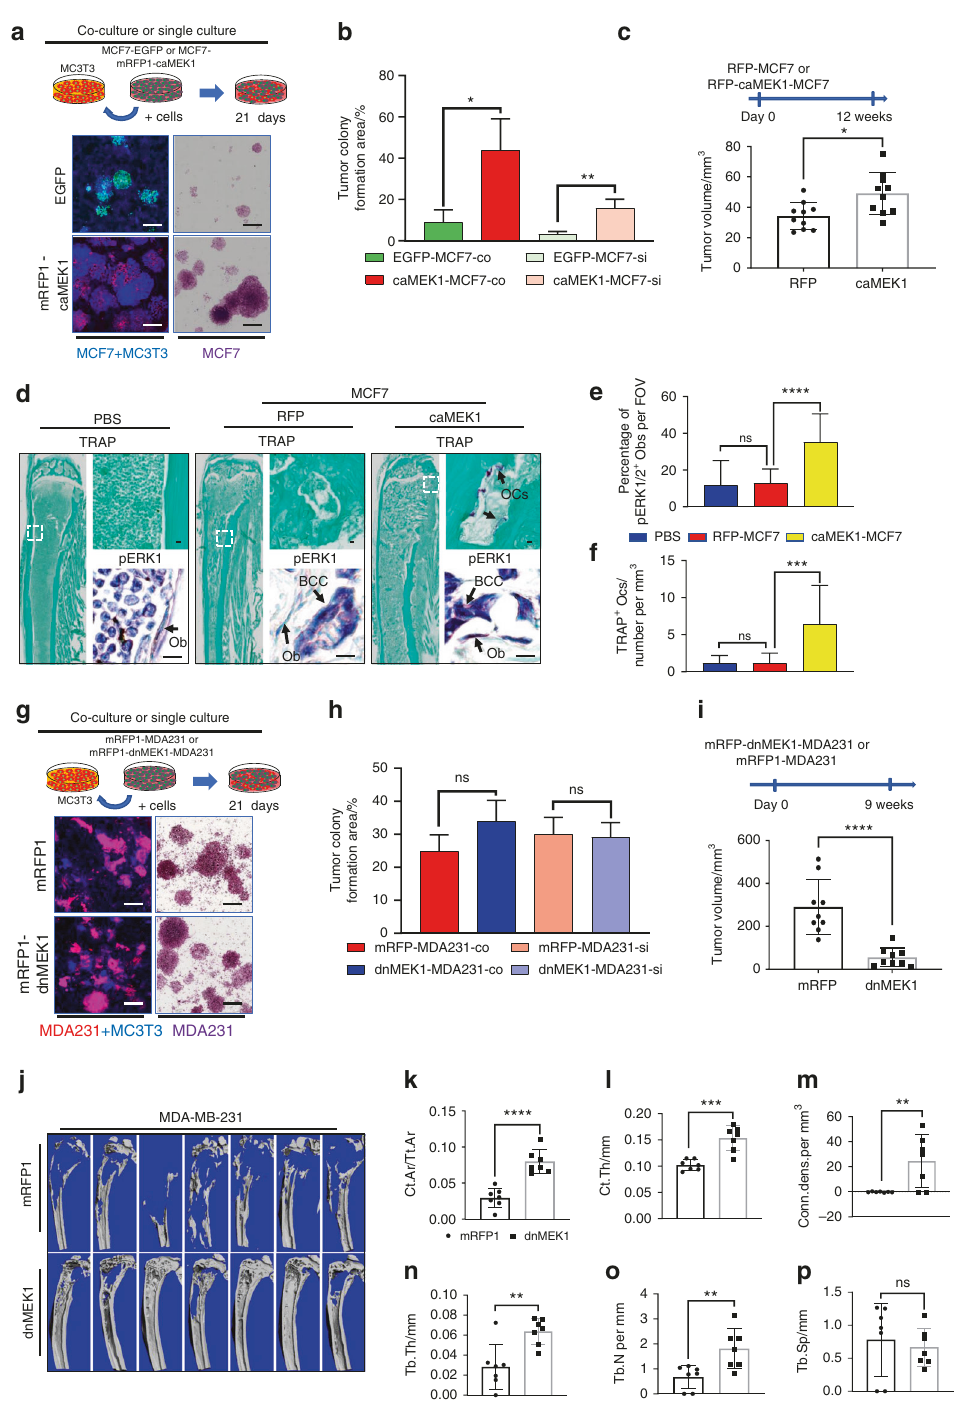
Fig. 4 MEK1/ERK1/2-mediated in fl ammatory interactions between aggressive breast cancer cells and osteoblasts accelerate bone destruction and cancer growth. a ERK1/2 activation in MCF7 cell growth under both single culture conditions and coculture conditions. b BCC colony formation was quanti fi ed by colony formation area. The mean colony area size was computed from images from the experiment in ( a ). Scale bar, 200 μ m. c caMEK1 expression in MCF7 cells in bone destruction and cancer growth. n = 10 mice per group. d pERK1/2 immunostaining and TRAP staining of tibiae harvested from the mRFP-MCF7- or mRFP-caMEK1-MCF7-exposed mice. Scale bar: 100 μ m. e Quanti fi cation of TRAP + osteoclast number under different experimental conditions. TRAP + osteoclast number calculated from images from the experiment in ( d ). f Quanti fi cation of pERK1/2 + osteoblasts in murine tibiae with breast cancer cells. pERK1/2 + osteoblast number calculated from images from the experiment in ( d ). g dnMEK1 expression in MDA231 cells grown under both single culture conditions and coculture conditions. h BCC colony formation was quanti fi ed by the colony formation area. The mean colony area size was computed from images from the experiment in ( g ). Scale bar, 200 μ m. i dnMEK1 expression in MDA231 cells in bone destruction and cancer growth. n = 9 mice per group. j Micro-CT images of tibiae harvested from nonmetastatic tumor-bearing and tumor-bearing mice 9 weeks after injection. Cortical area fraction Ct.Ar/Tt. Ar ( k ), cortical thickness ( l ), connectivity density ( m ), trabecular thickness ( n ), trabecular number ( o ), and trabecular separation ( p ) were determined using a Scanco μ CT 35 system. n = 7 mice per group. P values were calculated using the two-tailed t -test in Fig. 4b, c, h, I, k, l, m, n, o, and p. One-way ANOVA was performed with Dunnett ’ s multiple comparisons in Fig. 4e and